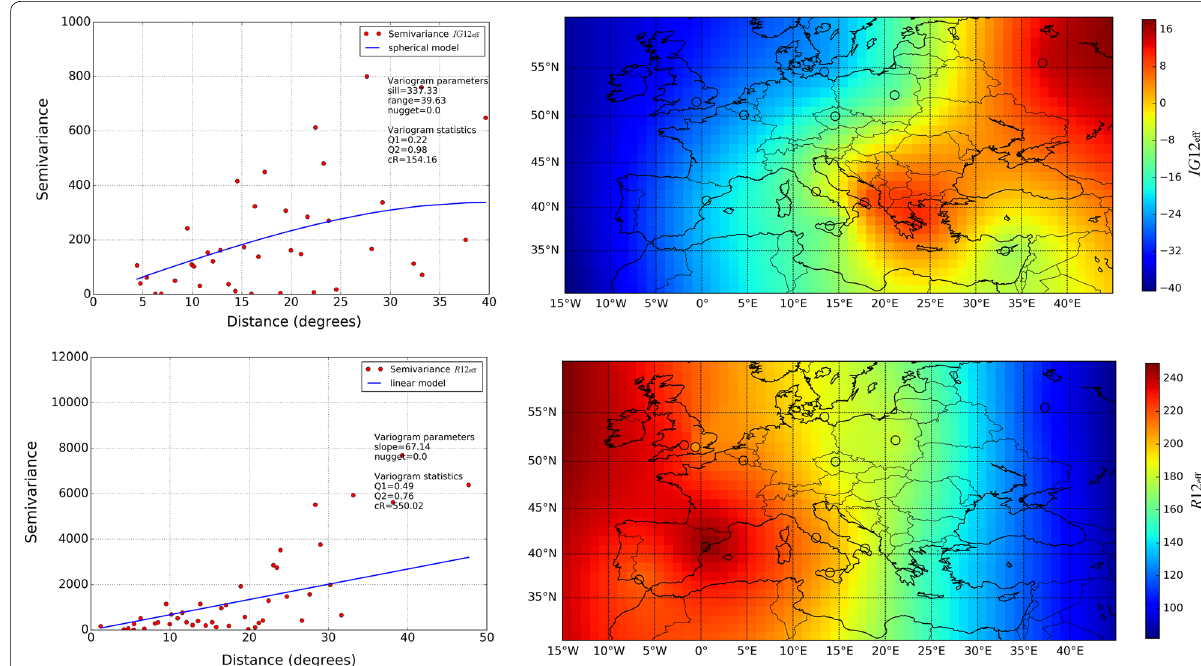
Fig. 7 Examples of effective index variograms and maps passing the NQCR selection procedure. (top left) Example of spherical variogram model which has passed the NQCR procedure and (top right) corresponding map of IG 12eff on October 16, 2016, at 12:00 UT. (bottom left) Example of linear variogram model which has passed the NQCR procedure and (bottom right) corresponding map of R 12eff on March 17, 2015, at 11:00